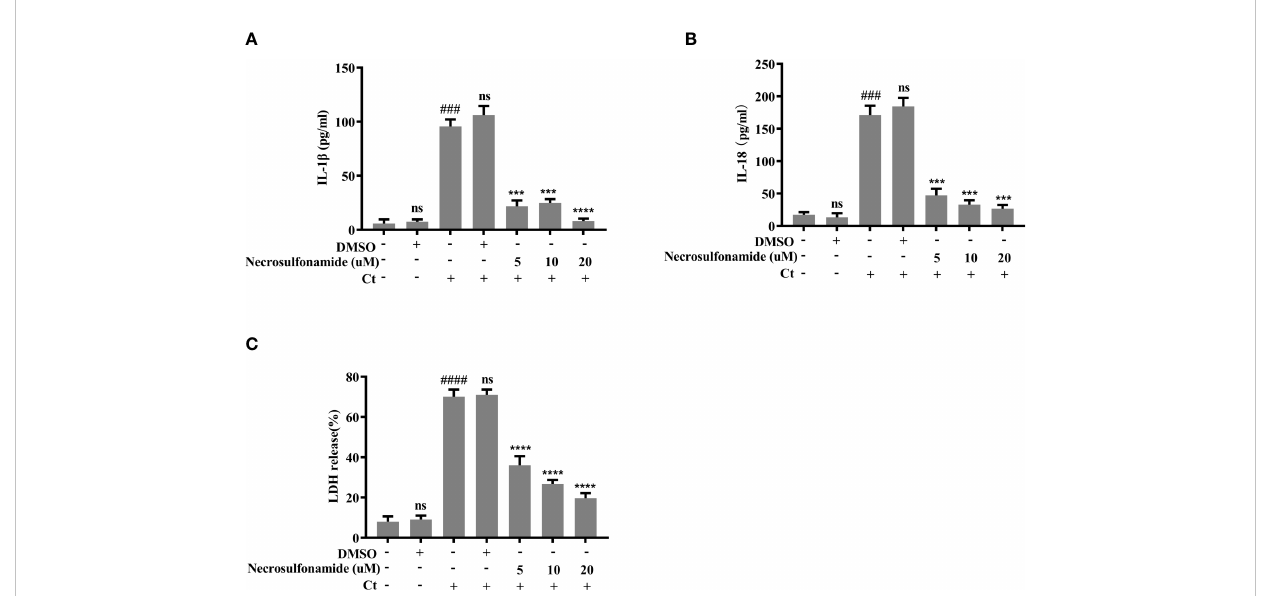
FIGURE 3 Chlamydia-induced pyroptosis is dependent on the activation of GSDMD. For (A – C) , RAW264.7 cells were pretreated with Necrosulfonamide for 30 minutes, then infected with C. trachomatis (MOI=5) for 12 hours. Same concentration of Necrosulfonamide was maintained throughout the rest of the infection. (A, B) . ELISA analysis showed IL-1 b and IL-18 secretion in culture supernatant in RAW264.7 cells. (C) . LDH release in supernatant was measured to estimate cell death. ### P<0.001, #### P<0.0001 vs the control group, ***P<0.001, ****P<0.0001, vs the Ct group. ns represents no signi fi cance.